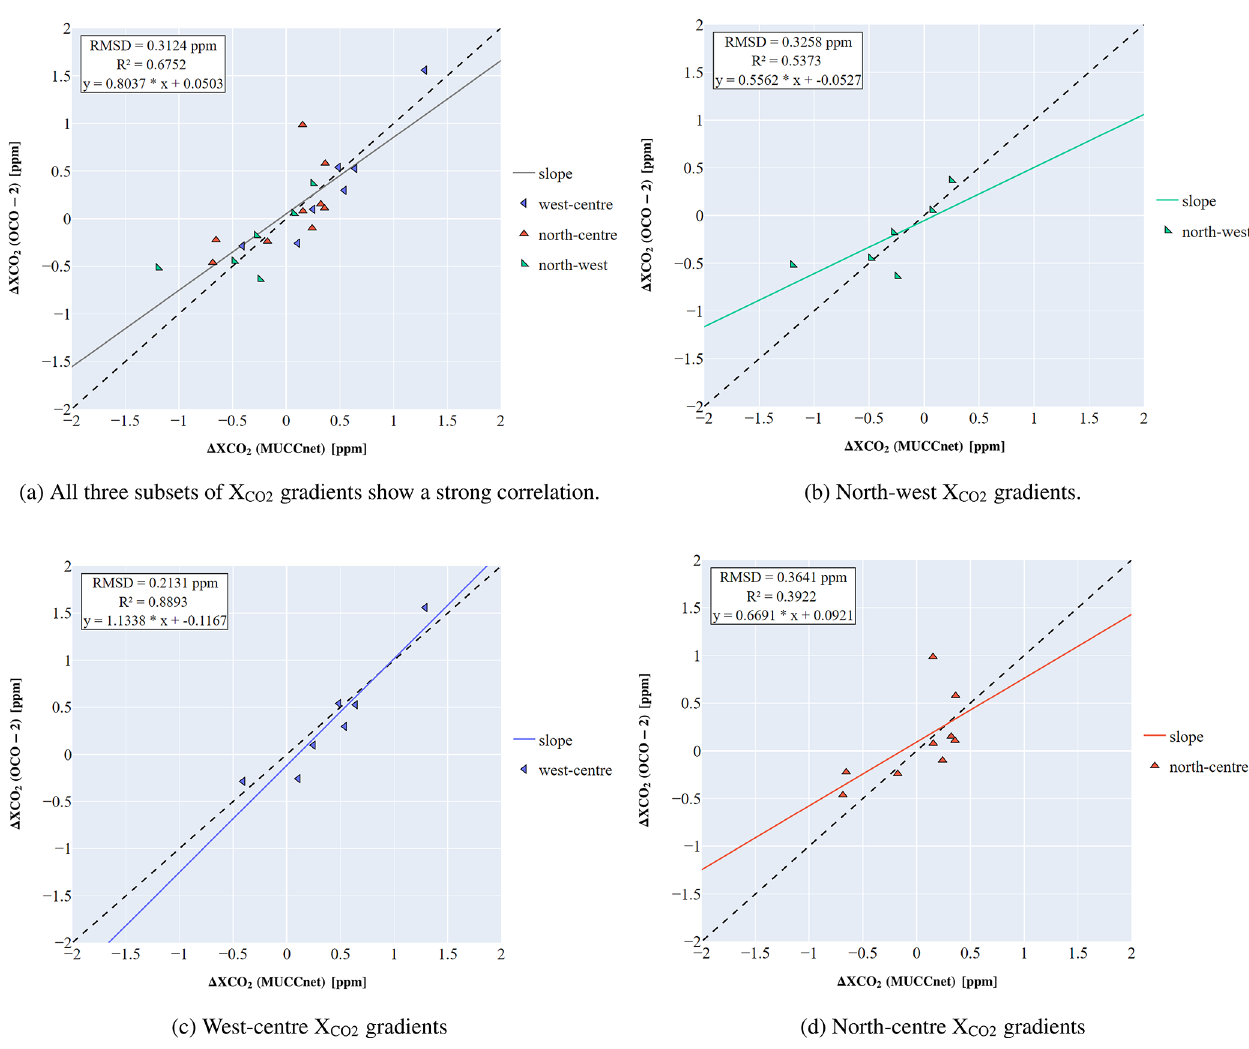
Figure 12. Linear regression results of spaceborne and ground-based X CO differences. Depending on the subset of gradients we observe 2 moderate to very strong correlation between ground-based and spaceborne gradients. These differences in agreement are caused by single outliers, which impact the regression results due to the small sample size and low absolute gradients in